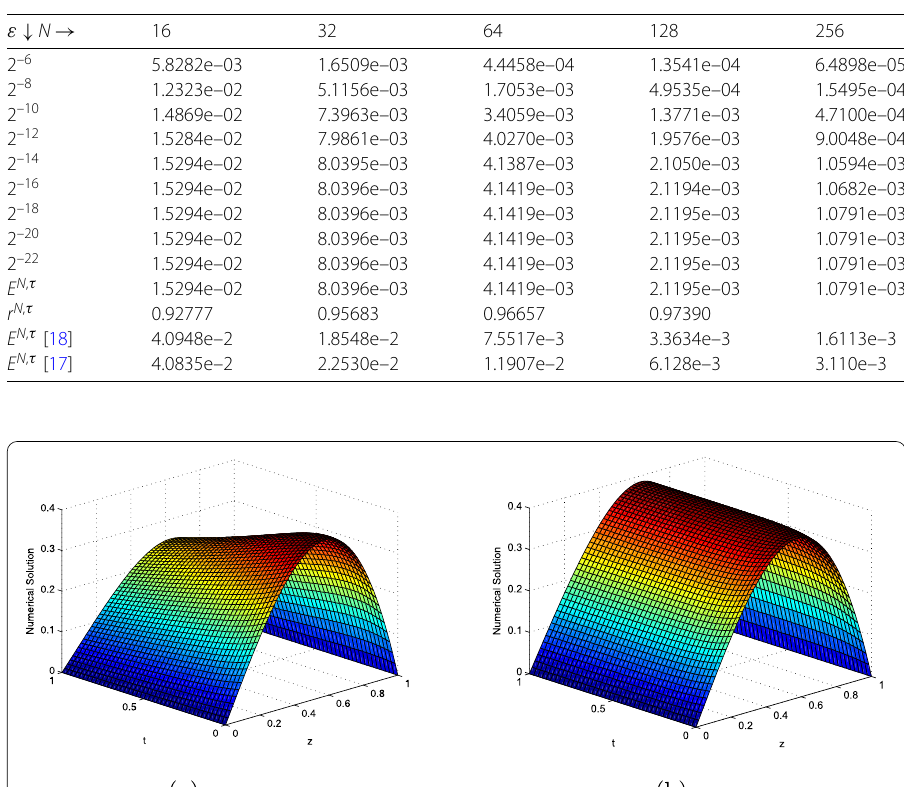
Table 4 E N , τ ε , E N , τ , and r N , τ for Example 5.3 with τ = 0.0001